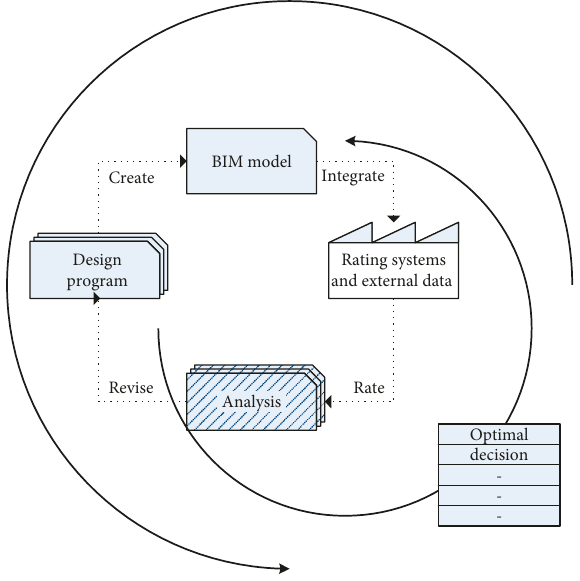
Figure 2: Sustainable infrastructure design